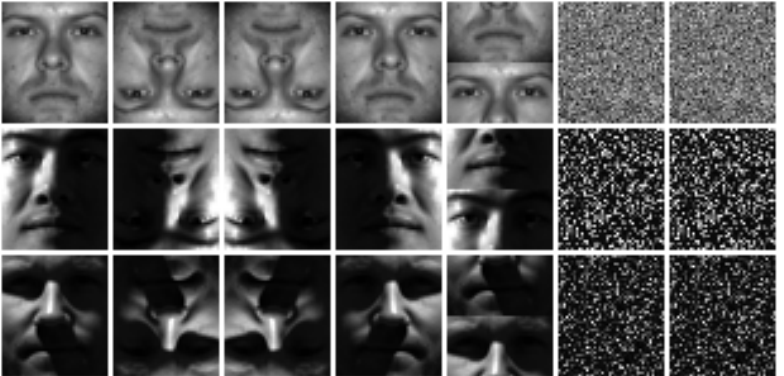
Figure 3. Sample images from the Extended Yale B face database and their variants. The first column shows the sample images and the remaining columns show their